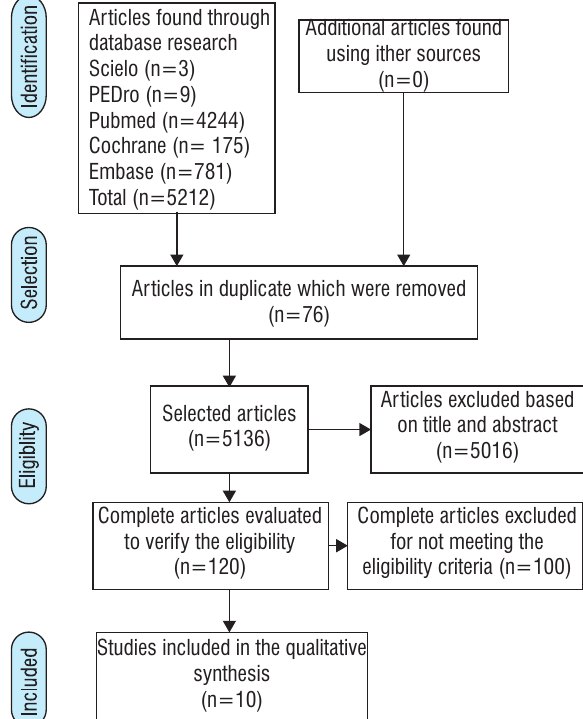
Figure 1 - Flowchart of the studies included in this review